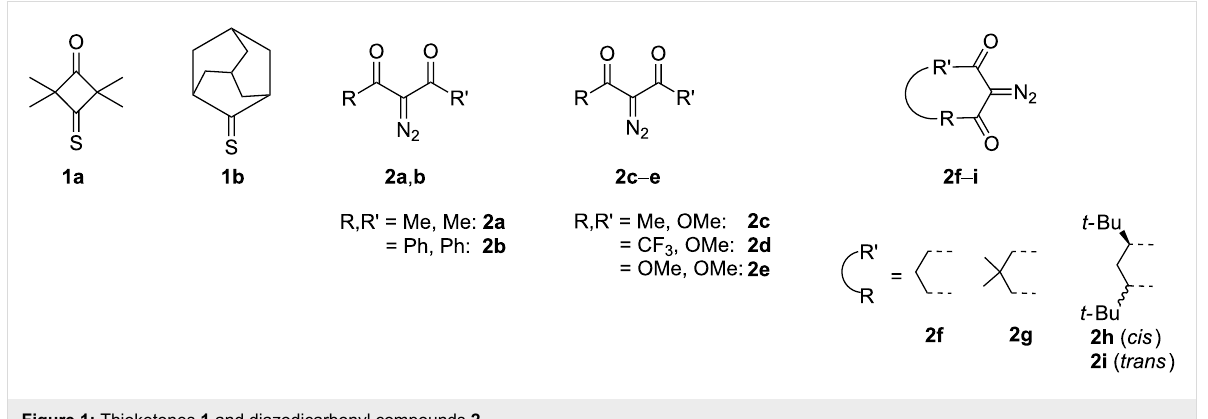
Figure 1: Thioketones 1 and diazodicarbonyl compounds 2